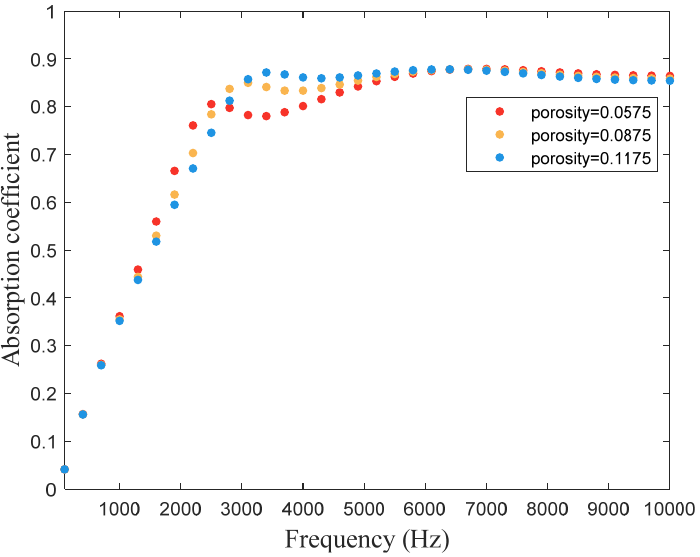
Figure 18. Influence of porosity of micro perforated plate of the hybrid metastructure on the struc- ture’s sound absorption coefficient.